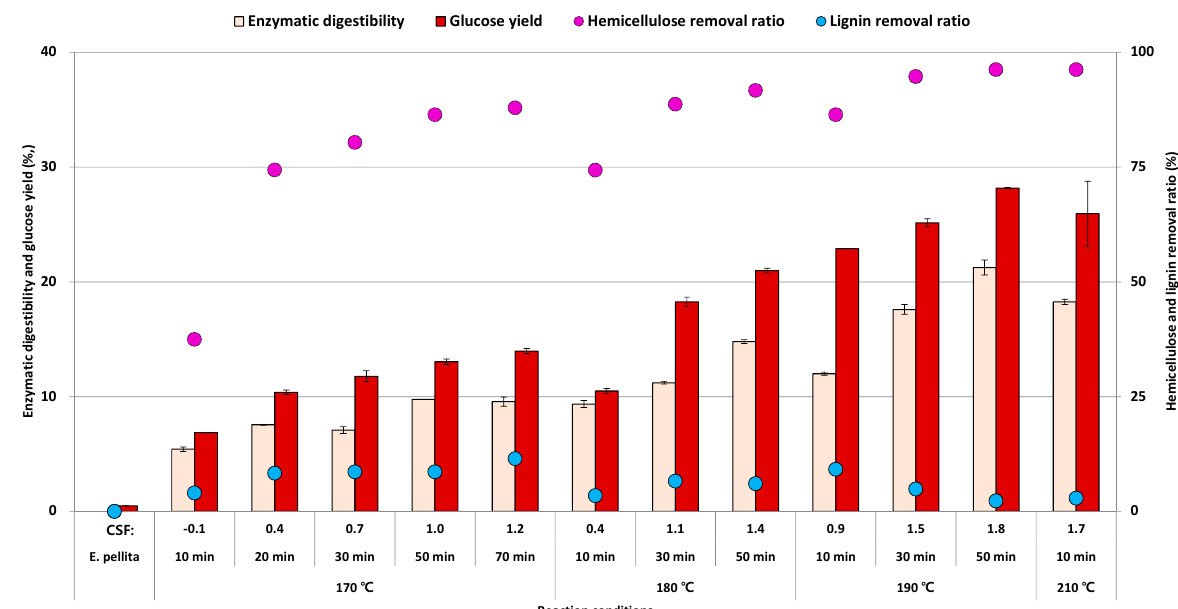
Figure 6. Enzymatic digestibility (%, based on a dry weight of substrate) and glucose yield (%, based on the glucose content in the initial biomass) from E. pellita and solid fractions after LHW treatment with hemicellulose and lignin removal ratio (%, based on the content in the initial biomass).